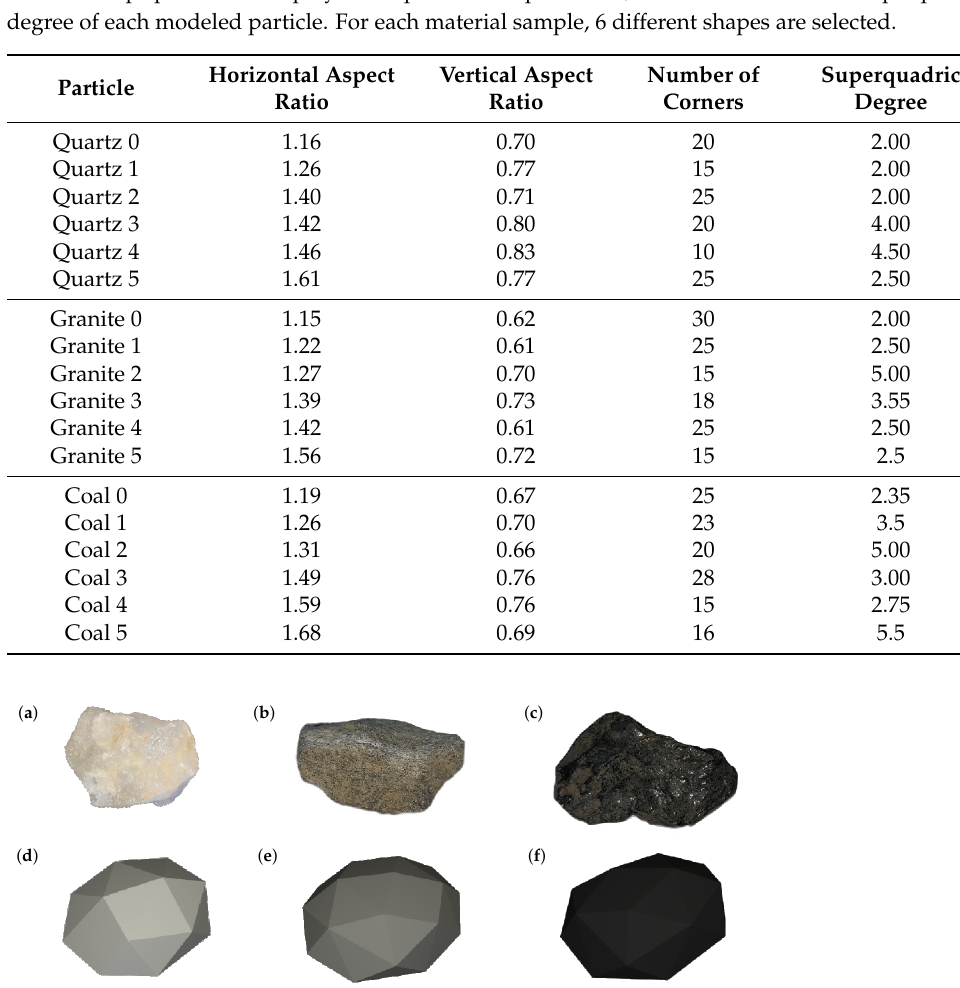
Figure 4. Particle shape: photographs of ( a ) quartz, ( b ) granite and ( c ) coal samples; and images of the modeled geometries ( d ) Quartz 0 particle, ( e ) Granite 0 particle and ( f ) Carbon 0